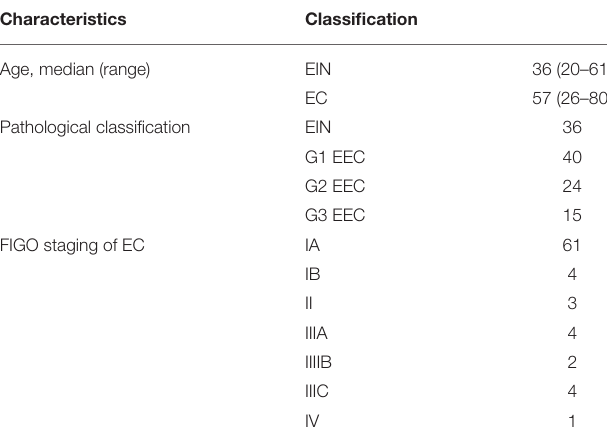
TABLE 1 | Patient demographics in the high-throughput sequencing